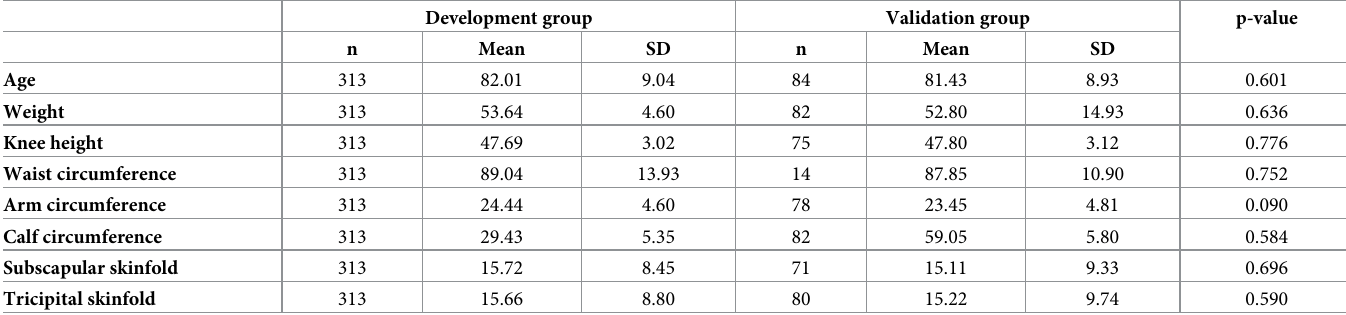
Table 4. Comparison of anthropometric data collected in the development and validation groups.